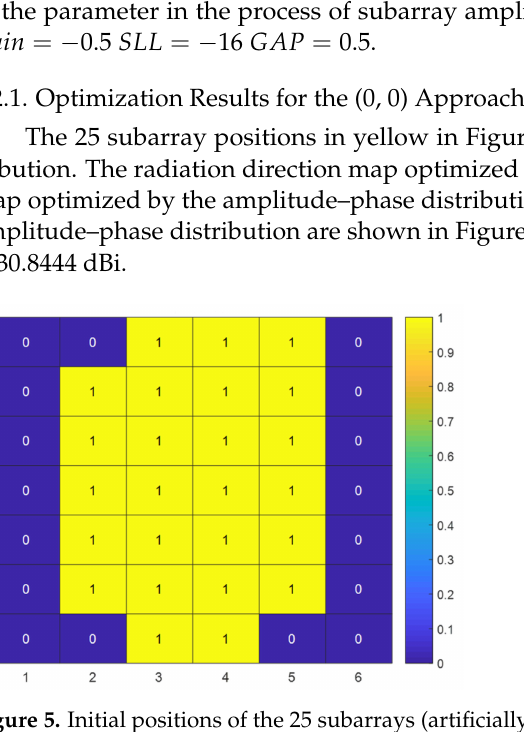
Figure 5. Initial positions of the 25 subarrays (artificially selected).